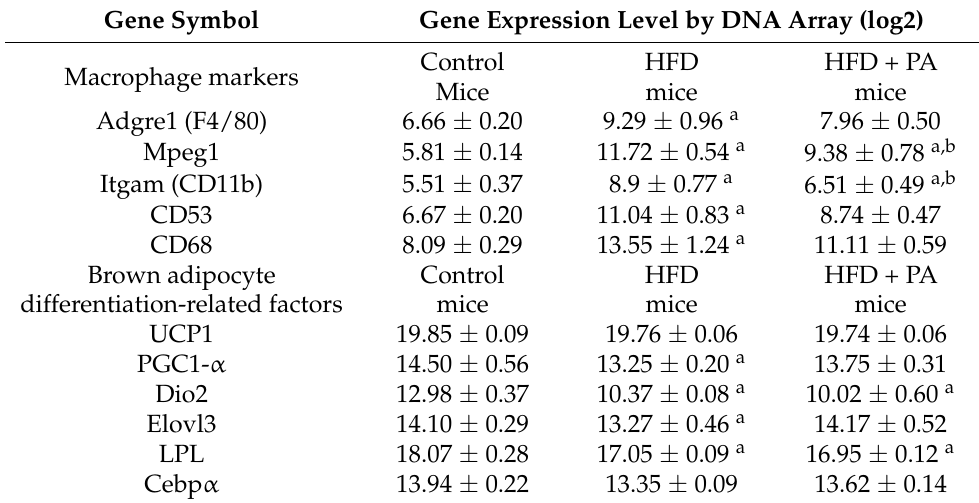
Table 4. Expression levels of mRNA for macrophage markers and brown adipocyte differentiation- related factors in the interscapular BAT of control, HFD, and HFD + PA mice. Gene Symbol Gene Expression Level by DNA Array (log2) Macrophage